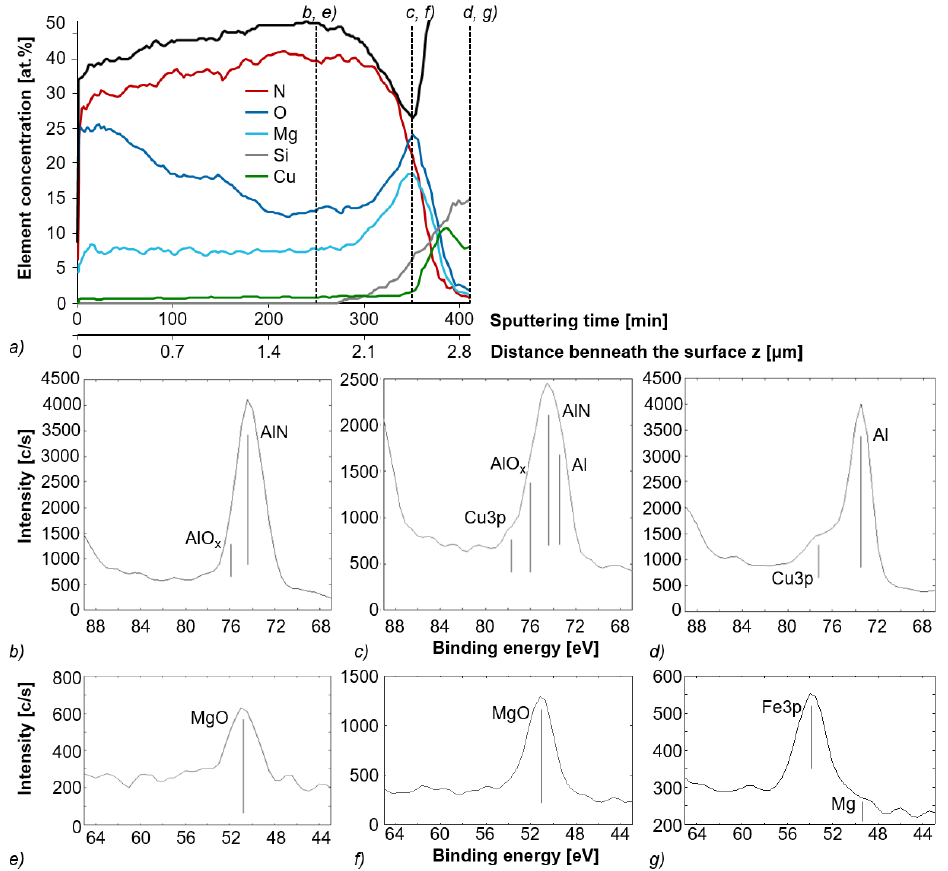
Figure 3. XPS analysis of a nitride layer with a thickness of approx. 2.2 µm (measuring area: 1 × 1 mm²; spot size: 100 µm; Al-K α radiation): ( a ) element concentration-depth profiles with indication of the 3 defined analysis depths z (dashed lines) based on the binding energies measured: ( b , e ) z ≈ 1.7 µm (AlN-layer); ( c , f ) z ≈ 2.5 µm (interface); ( d , g ) z ≈ 2.9 µm (substrate).